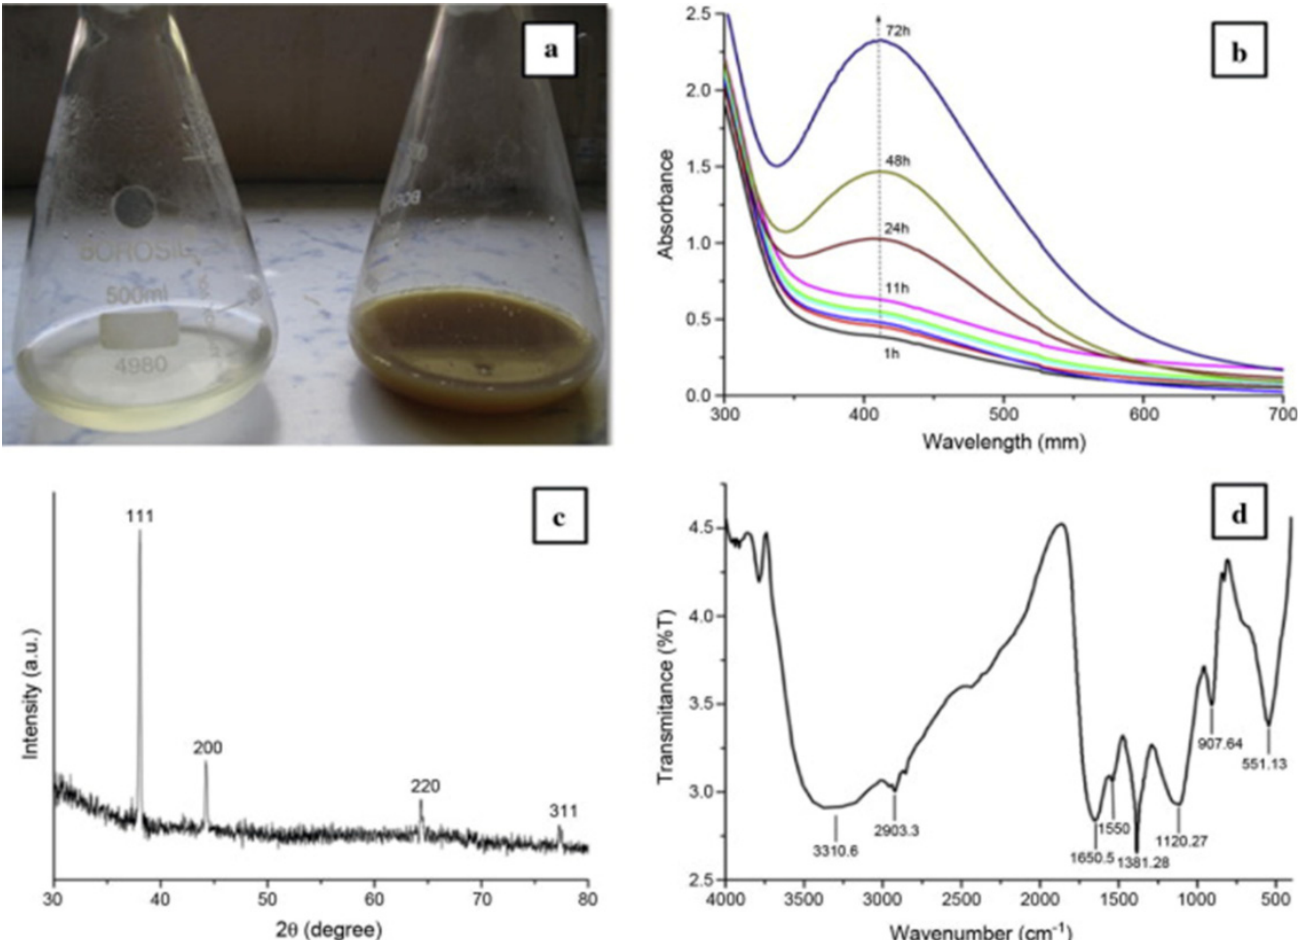
Figure 3. Visualization and characterization of silver nanoparticles. ( a ) The AgNPs formation; ( b ) UV–Vis spectra of AgNPs synthesized by Rhodococcus sp. with the absorption peak at 405 nm increasing with increased incubation time; ( c ) crystalline nature of AgNPs studied with XRD; ( d ) the FT-IR spectrum of AgNPs with the major peaks around 1550, 1650, 2903 and 3310 cm − 1 demonstrating the presence of amides on the surfaces of AgNPs [69].